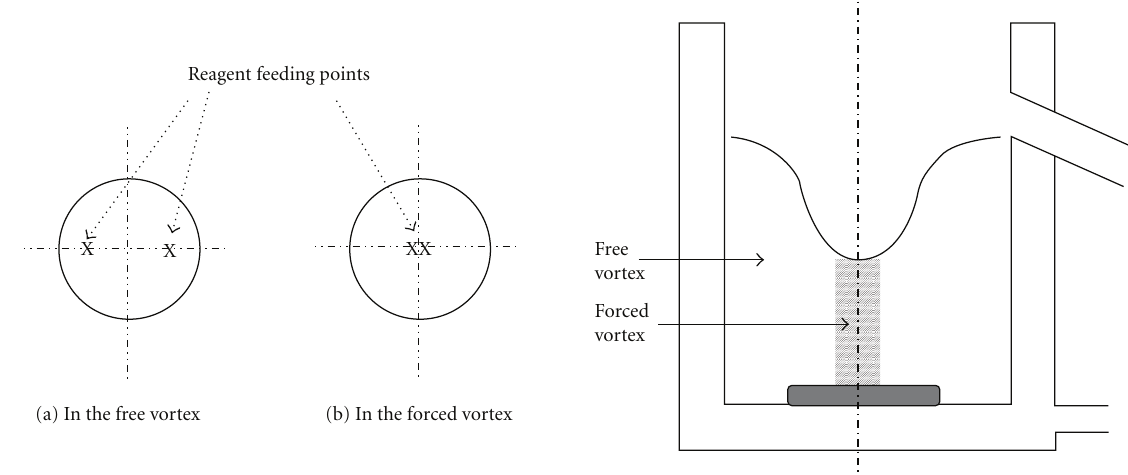
Figure 2: Feeding positions in the precipitator.